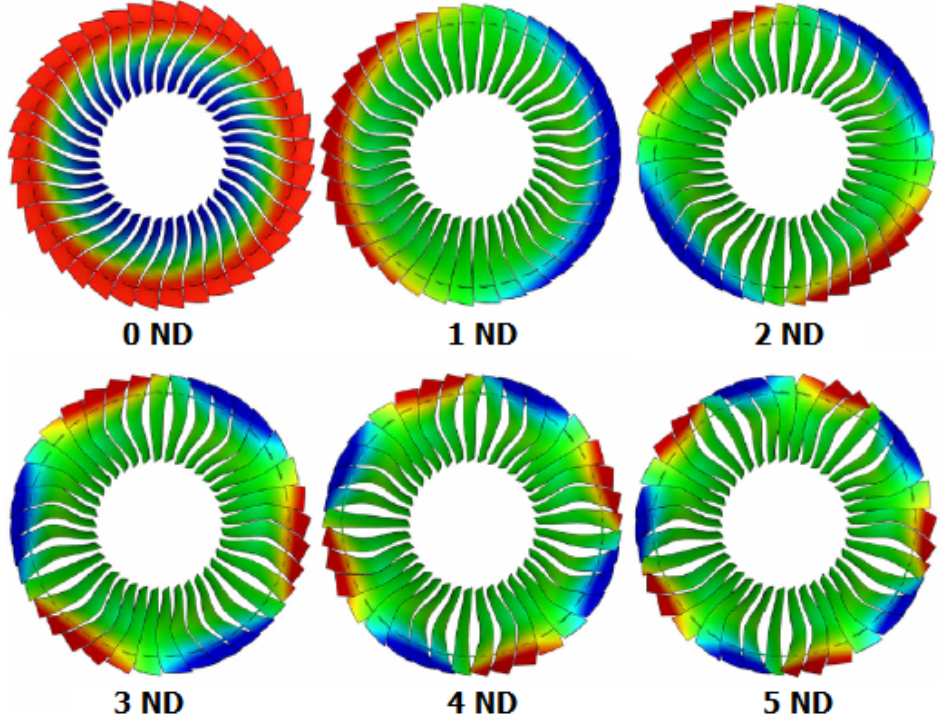
Figure 2. Vibration patterns with different NDs in a compressor bladed disk.